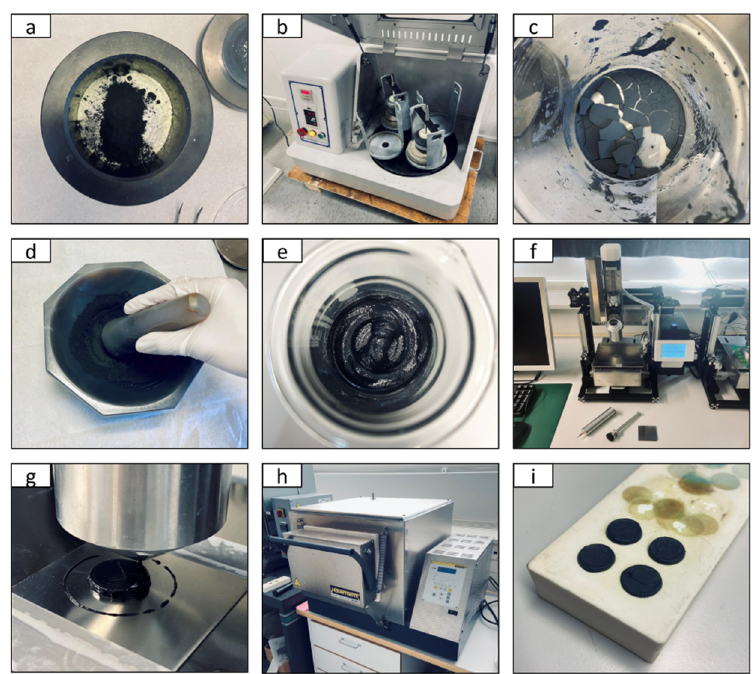
Figure 2. The steps involved in the fabrication of a single-layer ceramic fuel cell through extrusion- based 3D printer. ( a ) Ionic conductor and electrode powders in a milling jar, ( b ) mixing of powders in a ball milling machine using acetone solvent, ( c ) drying of the powders after ball milling step, ( d ) grinding of powders to fine particles, ( e ) preparation of paste of the composite material, ( f ) extrusion- based 3D printer used for fabrication of cells, ( g ) 3D printing of single-layer ceramic nanocomposite fuel cell, ( h ) oven used for sintering printed cells, ( i ) cells with appropriate density after the sintering process.